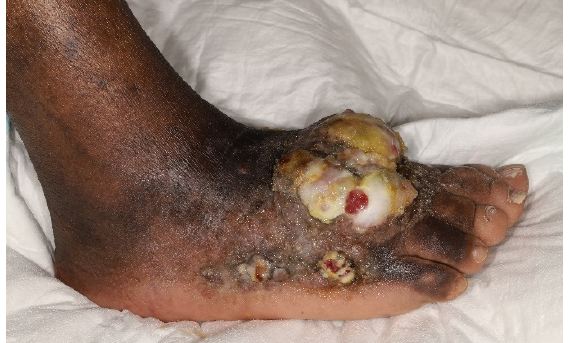
Figure 1. Clinical photograph of a 62-year-old immunocompetent man of African origin diagnosed with endemic Kaposi sarcoma. Note the well demarcated lobular central mass with surrounding nodular areas peripherally over the dorsum and the medial aspect of the right foot with accompanying lymphoedema of the entire lower limb. (Dermatology Department, AP-HP Hopital Saint-Louis—June 2019).